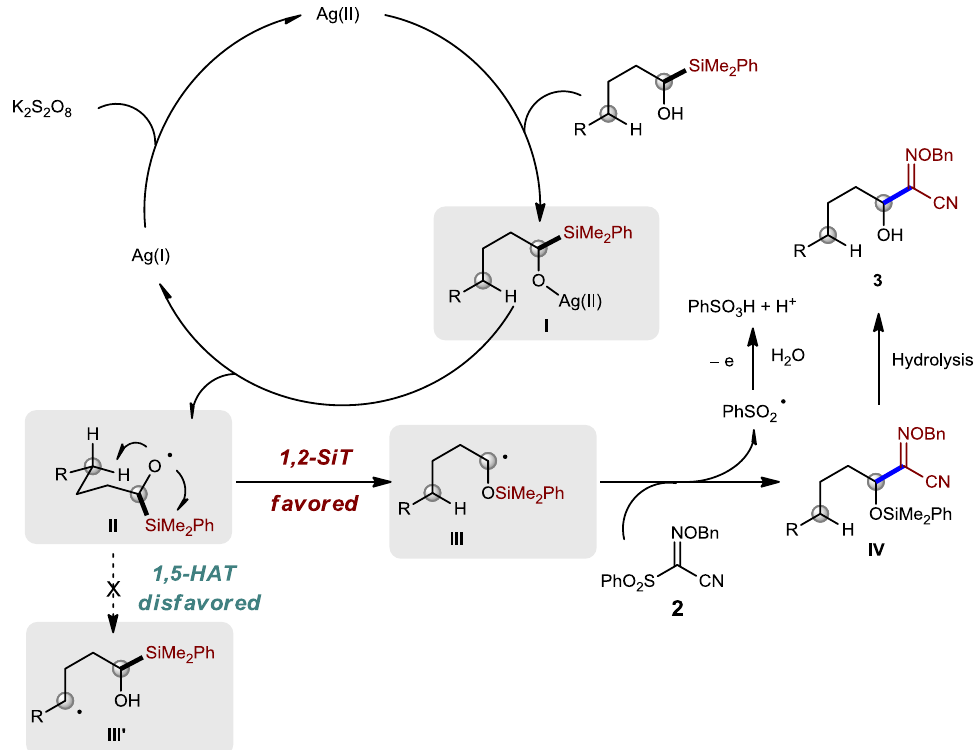
Fig. 6 Proposed mechanism. The proposed mechanism involves an Ag(I)/Ag(II) catalytic cycle and